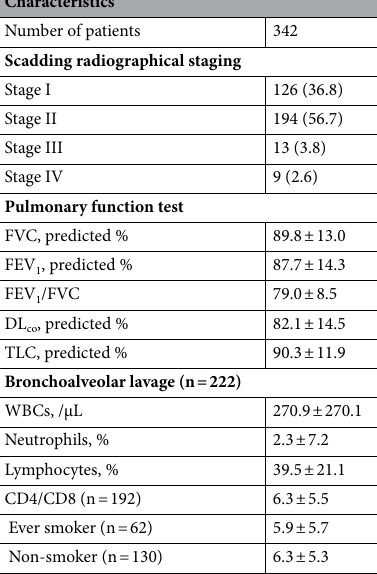
Table 2. Pulmonary involvement of patients with sarcoidosis. FVC, forced vital cavity; FEV 1, forced vital capacity in 1 s; DL CO , diffusion capacity of the lung for carbon monoxide; TLC, total lung capacity; WBC, white blood cells.